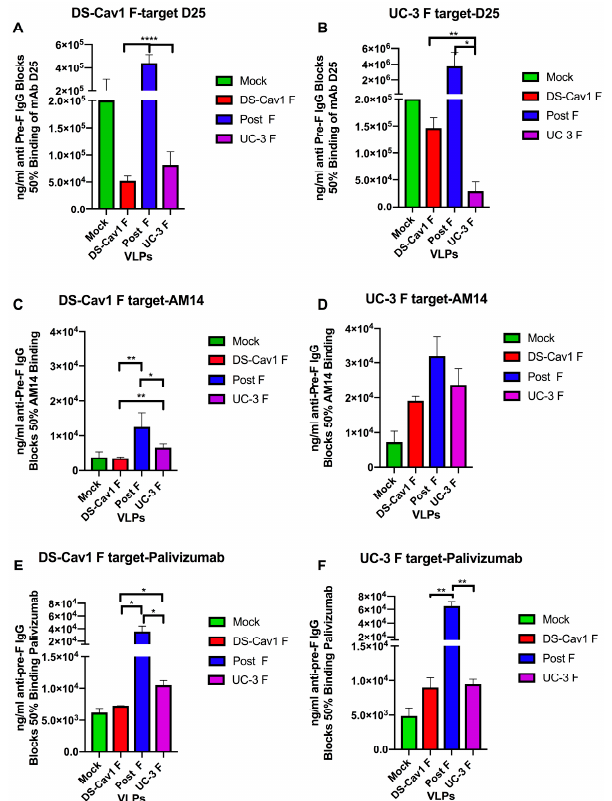
Figure 2. Blocking of binding of pre-fusion specific mAb by sera from VLP-immunized dams using di ff erent target antigens. Shown are the concentrations (ng / ml) of total anti-pre-fusion F binding IgG in VLP sera that blocked 50% binding of mAb D25 (panels A, B), AM14 (panels C, D), or palivizumab (panels E, F) to soluble DS-Cav1 F protein target (panels A, C, E) or soluble UC-3 F protein target (panels B, D, F) in ELISA. Determinations were done twice in parallel in order to accurately compare results with di ff erent targets. The results are the mean of the two separate determinations with standard deviations indicated. *** p < 0.0005; ** p < 0.005; * p <